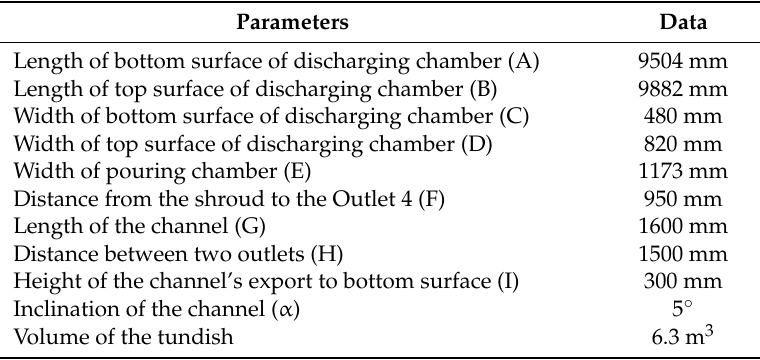
Figure 2. Schematics of the tundish: ( a ) solid view, ( b ) top view and ( c ) partial view. Table 1. Geometry of the prototype tundish.